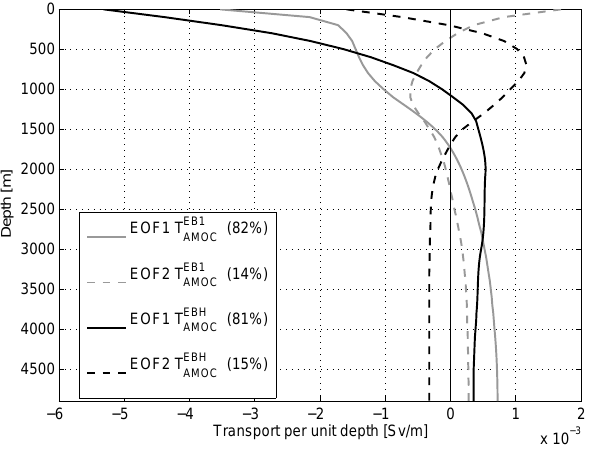
Fig. 11. Vertical structure of the first and second vertical EOF modes of the anomalies (time mean subtracted) of the transport per unit depth profiles derived from EB1 and EBH ( T EB1 ) . The modes have been multiplied by the standard devi- T EBH AMOC ation of the corresponding principal components. The explained variance by each mode is given in brackets in the figure